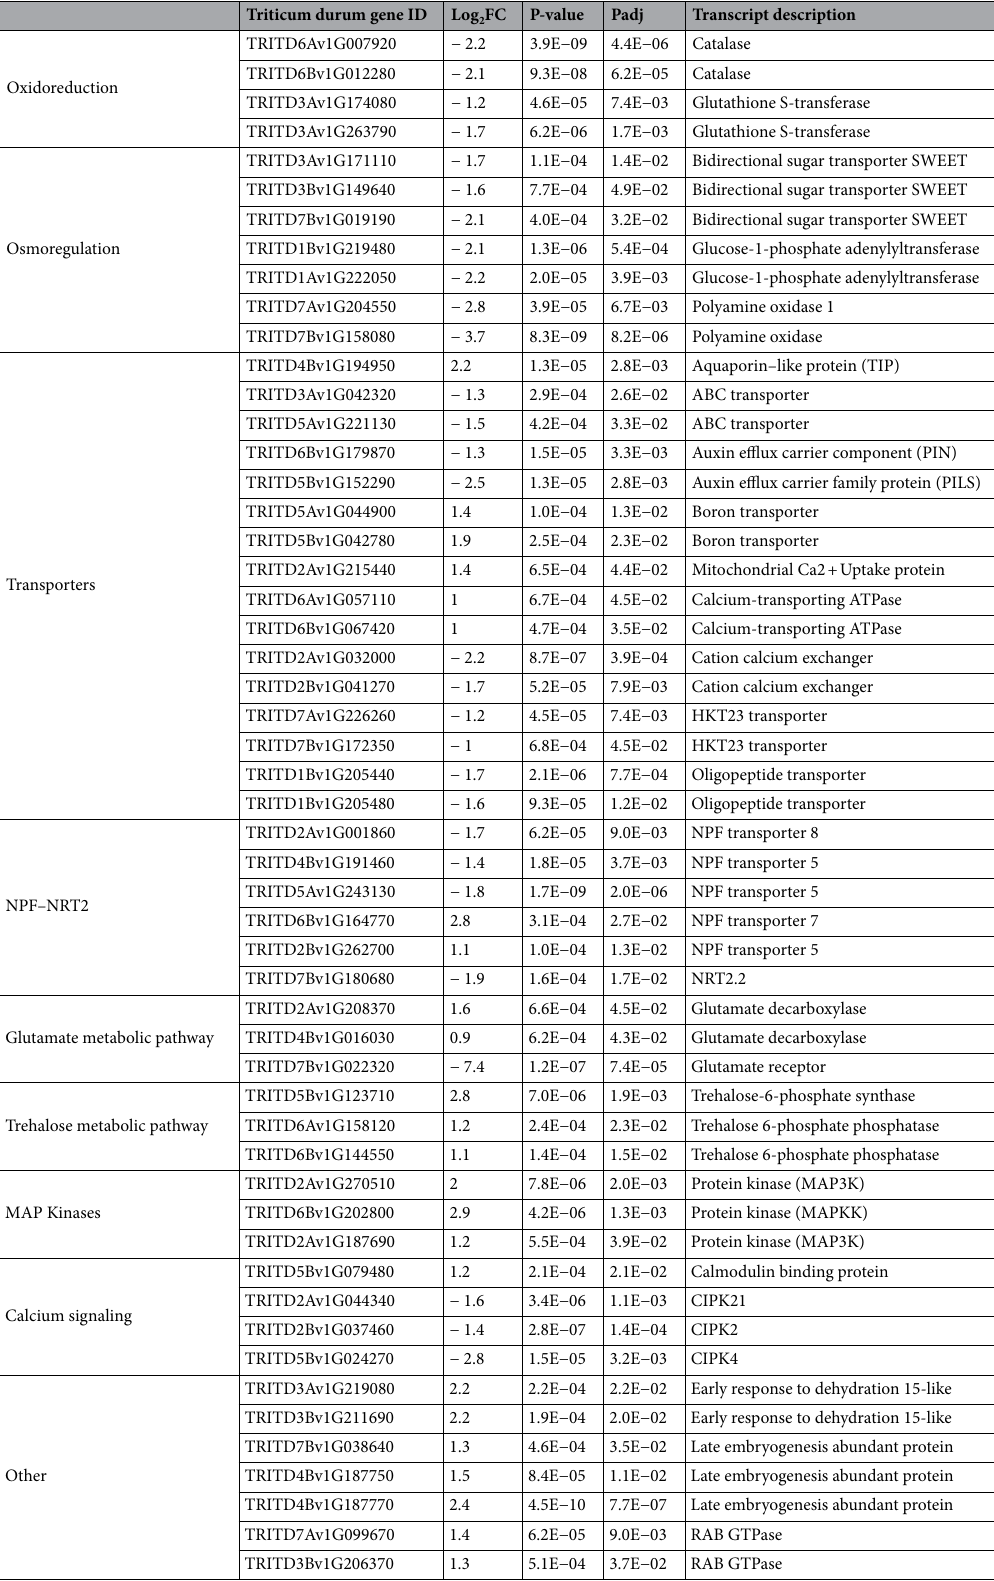
Table 1. Key genes involved in the response to salt stress found differentially expressed between AM + and AM− samples. Log 2 Fold Change (Log 2 FC), P-value, and Deseq2 adjusted P-value (Padj) are